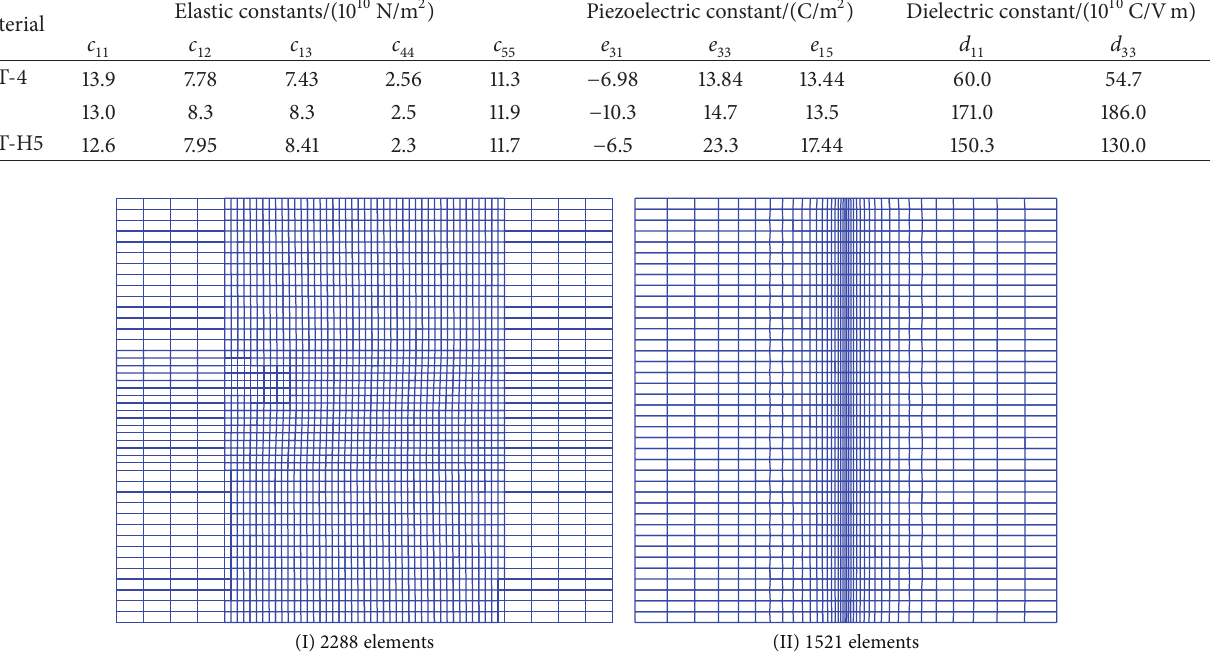
Figure 7: Mesh of the piezoelectric